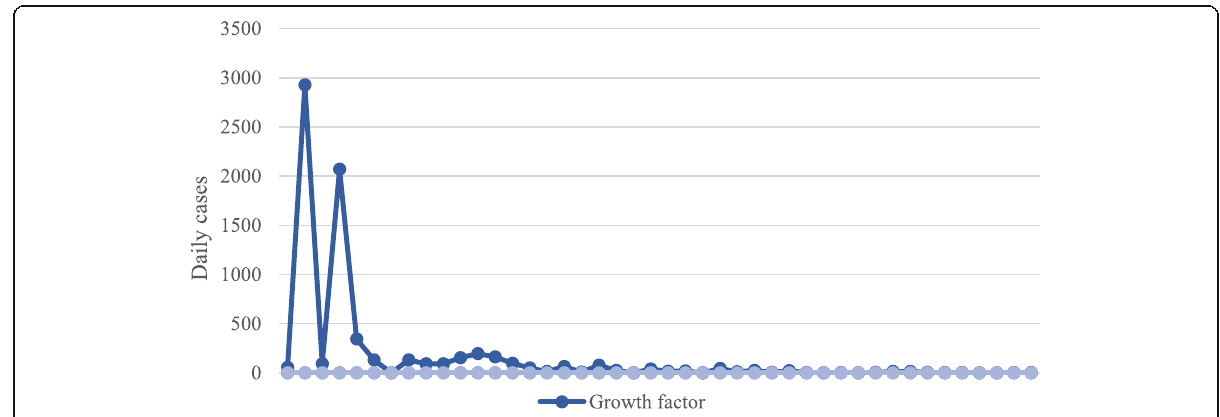
Fig. 6 Growth factor in COVID-19 (March 30,